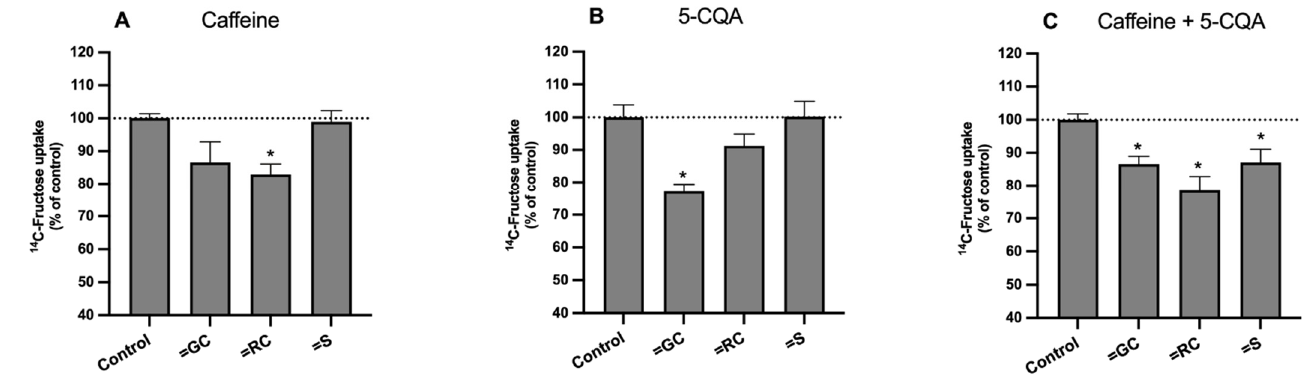
Figure 5. Effect of ( A ) caffeine, ( B ) 5-caffeoylquinic acid (5-CQA), and ( C ) a mixture of both (in the same concentrations present in the respective extracts (GC, green coffee; RC, roasted coffee; S, silverskin) on the uptake of 14 C-FRU by Caco-2 cells. Caco-2 cells were cultured for 24 h in the presence of the standards ( n = 6–9) or the respective solvent (control; n = 6–9). Uptake was measured by incubating the cells at 37 ◦ C with 100 nM 14 C-FRU for 6 min. Results are expressed as means ± SEM. *, Significantly different from control ( p < 0.05; Student’s t -test).